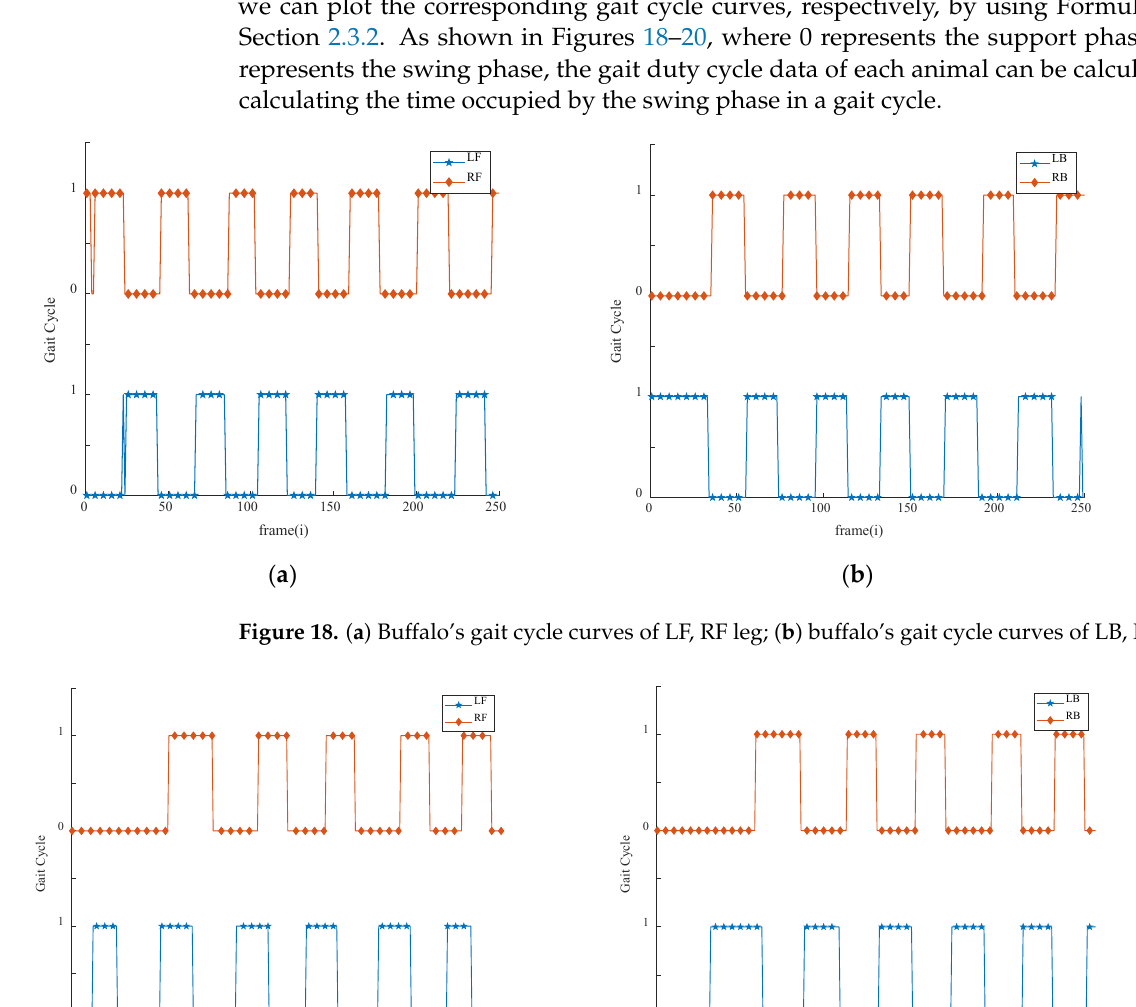
( b ) Figure 20. ( a ) Dog’s gait cycle of LF, RF leg; ( b ) dog’s gait cycle of LB, RB leg. We can calculate the gait duty cycle parameters for the buffalo, horse, and dog by using Formula (10) and Figures 18–20, and the results are shown in Table 7. Table 7. Gait duty cycle of buffalo, horse, and dog. Limb